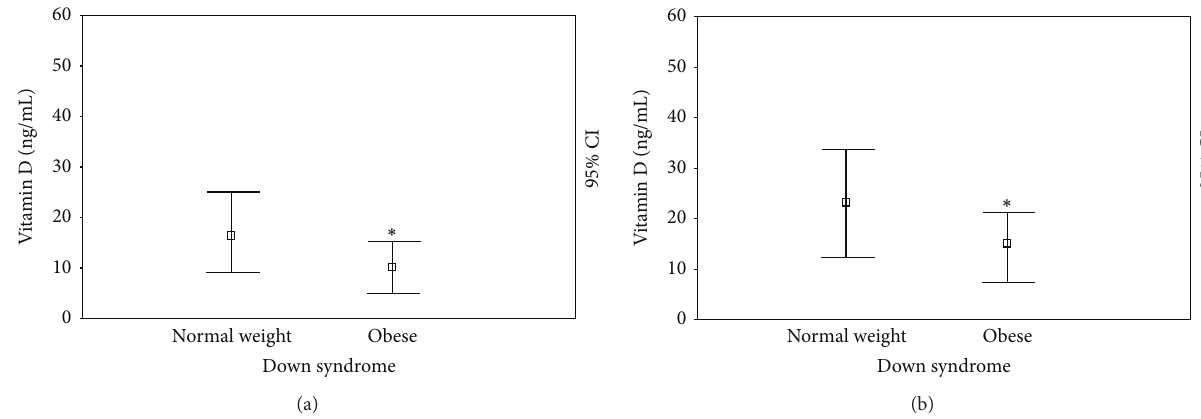
Figure 2: 25(OH)D levels (ng/mL) at cross-sectional (a) and longitudinal (b) evaluation in patients with Down syndrome and obesity and normal weight. ∗ 𝑃 < 0.05 ; ∗∗ 𝑃 < 0.005 ; ∗∗∗ 𝑃 < 0.001 .